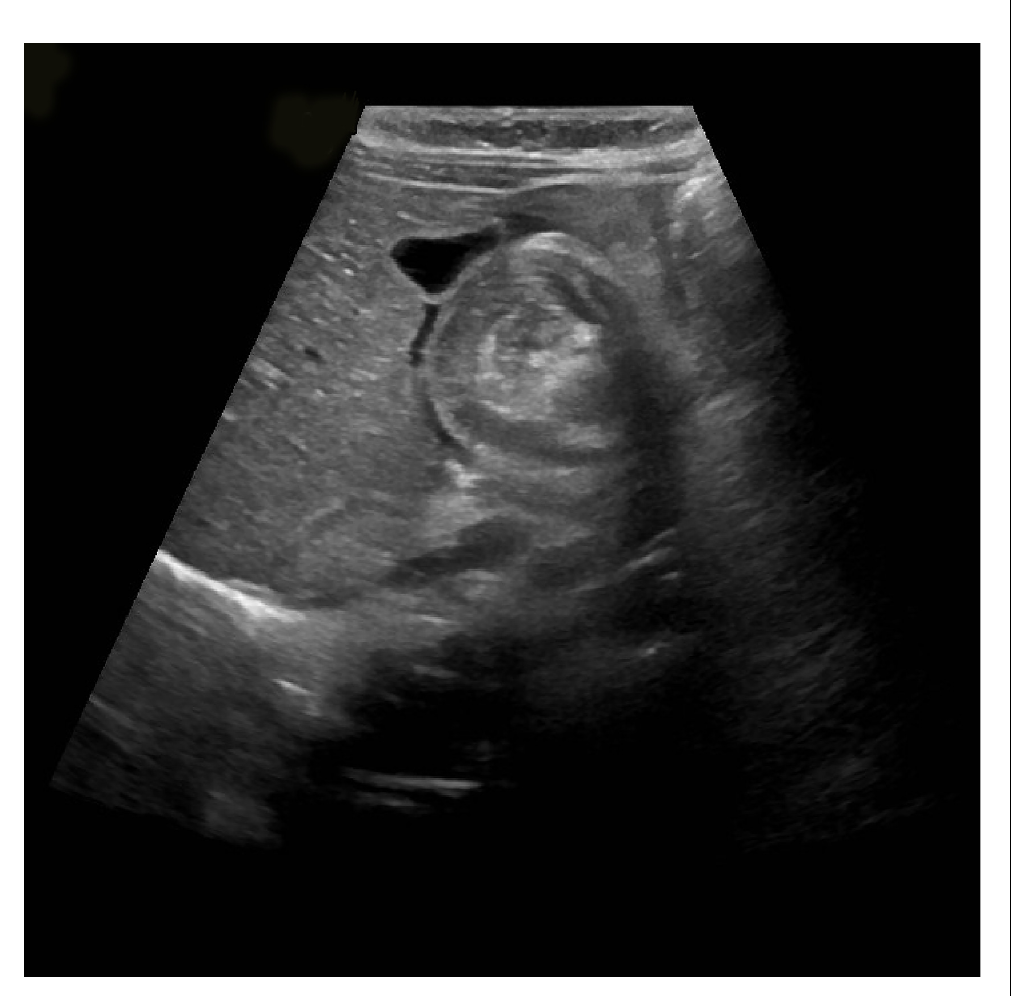
Figure 2. Ultrasound image showing characteristic target